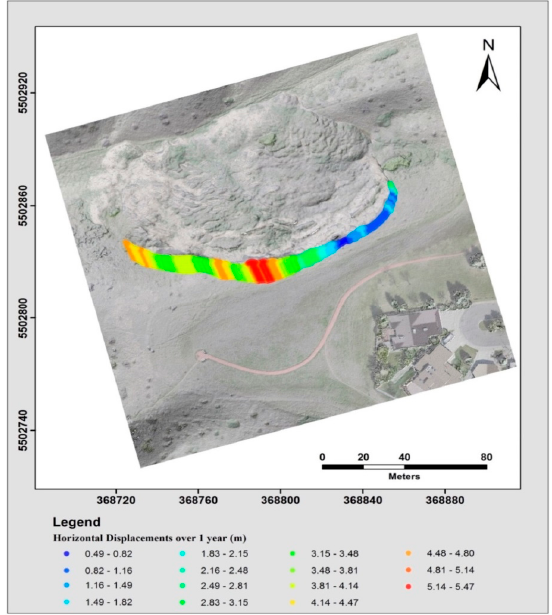
Figure 19. Horizontal displacement difference, scarp retreat, between the extracted scarps of May 2014 and May 2015 illustrating the surface changes and, therefore, the dynamics of the landslide.